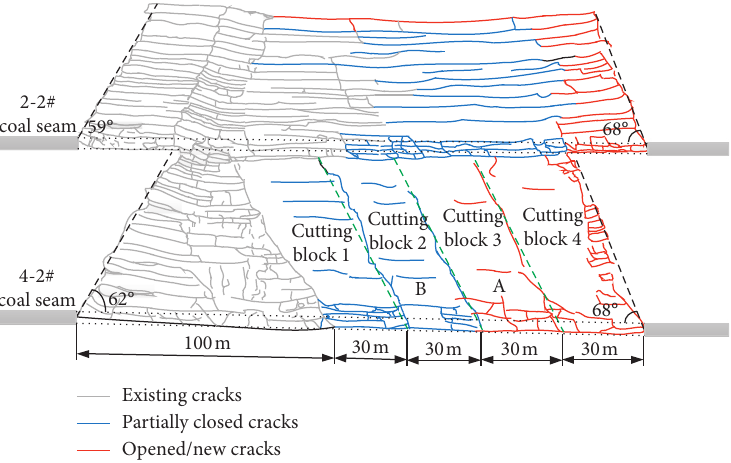
Figure 8: Structural sketch of the cutting blocks.